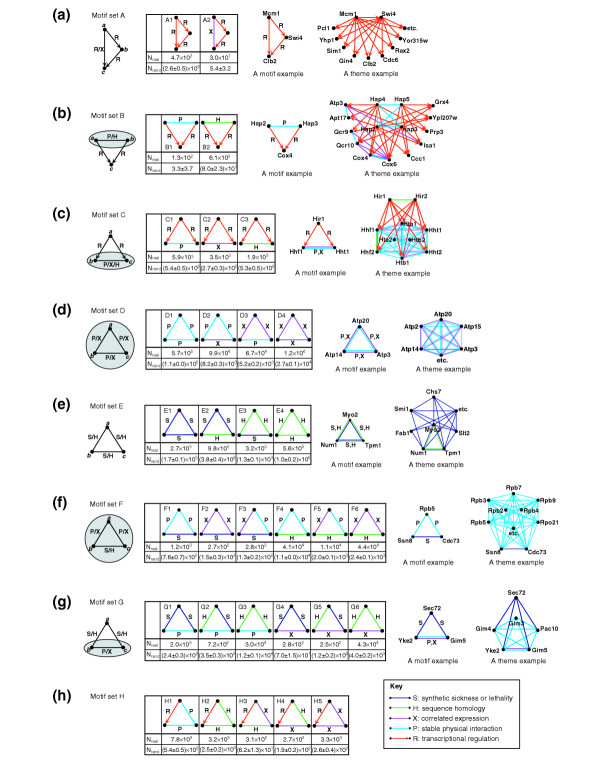
Three-node motifs and corresponding themes in the integrated S. cerevisiae network. (a) A motif corresponding to the 'feed-forward' theme; (b) motifs corresponding to the 'co-pointing' theme; (c) motifs corresponding to the 'regulonic complex' theme; (d) motifs corresponding to the 'protein complex' theme; (e) motifs corresponding to the theme of neighborhood clustering of the integrated SSL/homology network; (f) motifs corresponding to the 'compensatory complex members' theme; (g) motifs corresponding to the 'compensatory protein and complex/process' theme; (h) other unclassified motifs. Each of (a-g), from left to right, shows a schematic diagram unifying the collection of motifs in that set, the list of motifs with the motif statistics, a specific example of a subgraph matching one or more of these motifs, and a larger structure corresponding to the network theme. Each colored link represents one of the five interaction types according to the color scheme (bottom right). For a given motif, Nreal is the number of corresponding subgraphs in the real network, and Nrand describes the number of corresponding subgraphs in a randomized network, represented by the average and the standard deviation. A node labeled 'etc.' signifies that the structure contains more nodes with connectivity similar to the labeled node.